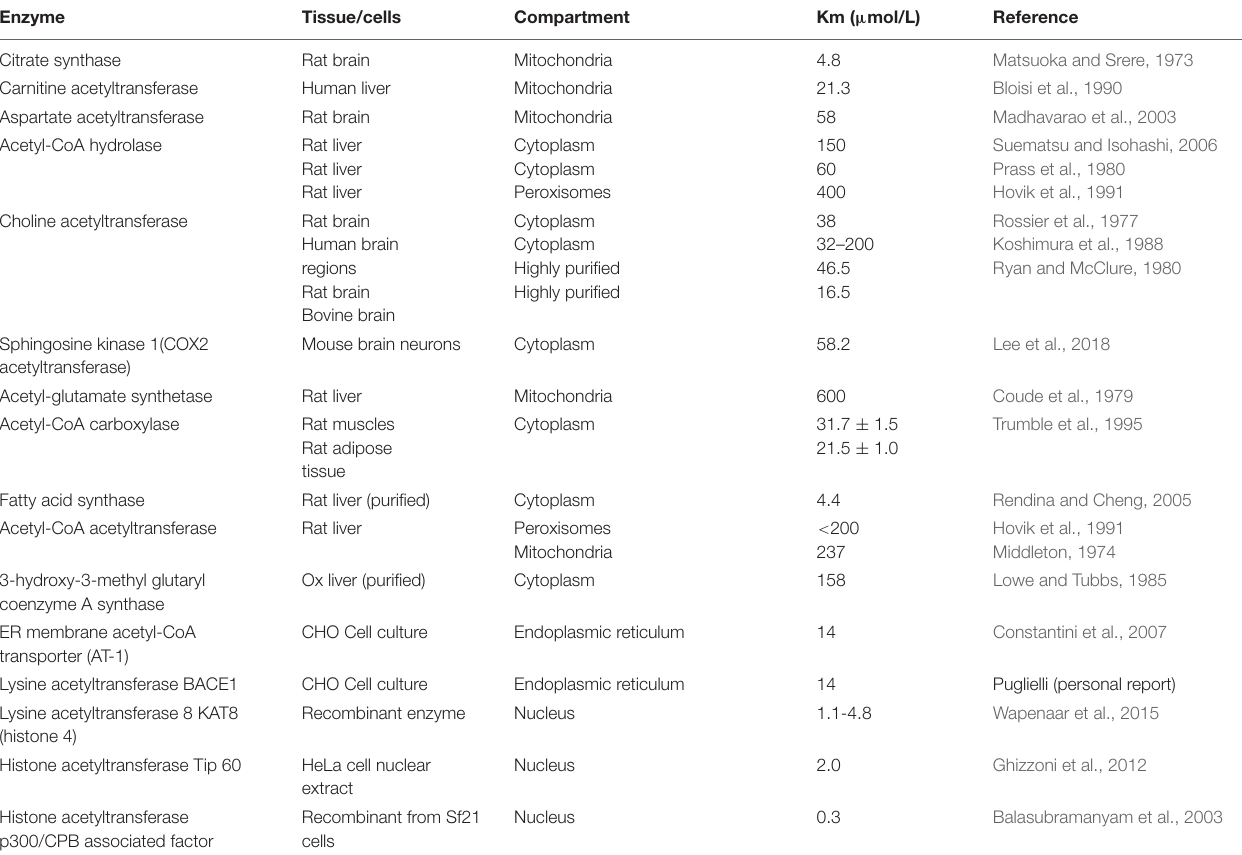
TABLE 1 | The acetyl-CoA Km values for acetyl-CoA consuming enzymes in different cellular compartments. Enzyme